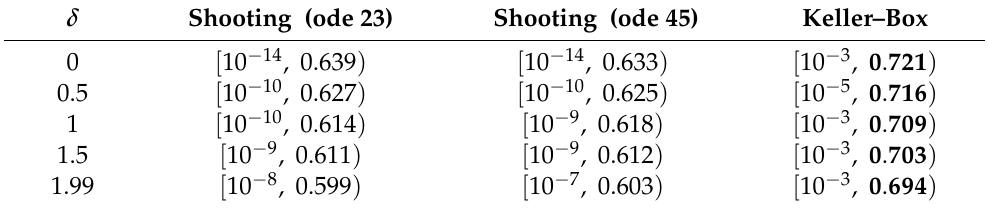
Table 5. Ranges of θλ 2 ensuring convergence with ghost solutions (shooting and Keller–Box procedures).